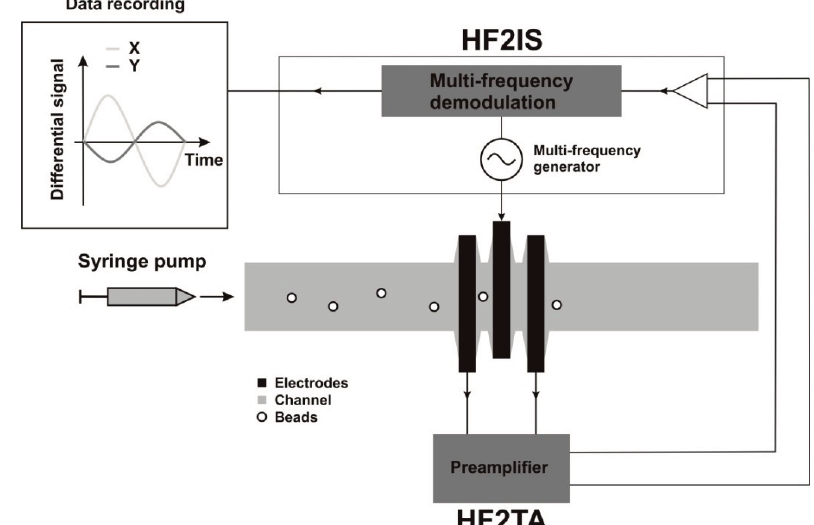
Figure 2. Schematic representation of the system. A syringe pump injects the sample into the system. The signal is generated by a multi-frequency lock-in amplifier, which also detects the signal. A current preamplifier (HF2TA, Zurich Instruments) is used to amplify the signal from the measuring electrodes before it is returned to the HF2IS Impedance Spectroscope (Zurich Instruments). A differential signal between the two measuring electrodes is recorded on a computer for further analysis by